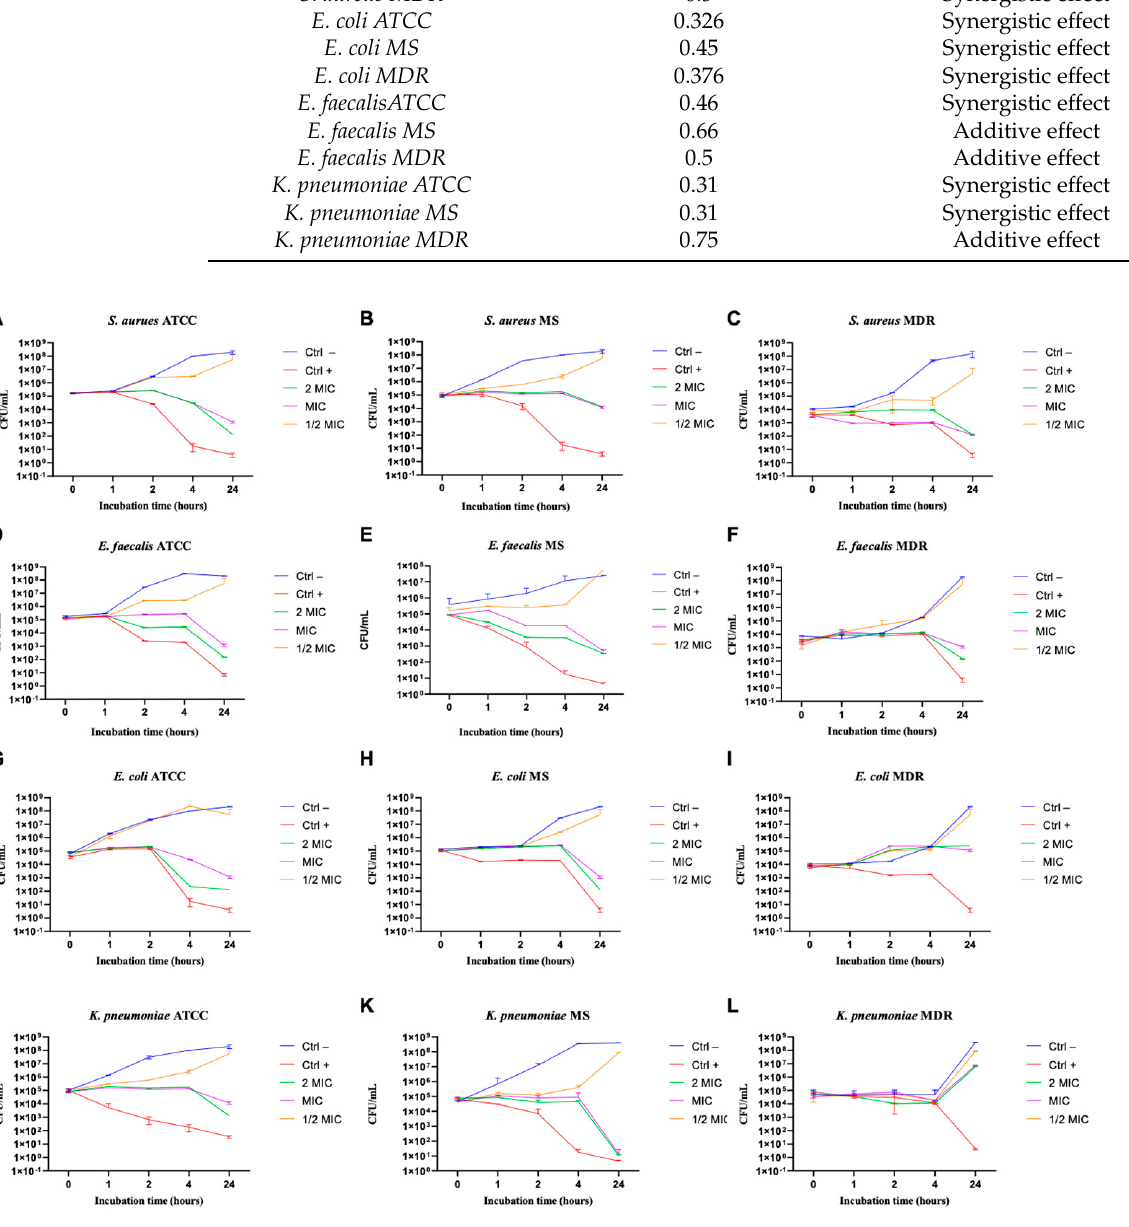
Figure 10. Bactericidal and bacteriostatic effect of AgPtNPs against different bacteria. ( A – C ) indicate the analysis against all S. aureus strains, ( D – F ) against E. faecalis , ( G – I ) against E. coli , and ( J – L ) against K. pneumoniae . Data are means of three independent experiments. CTR+ indicates bacteria treated with antibiotic, while CTR − represents not-treated bacteria. Data are relative to Ab- and represent the mean ± standard deviation (SD).